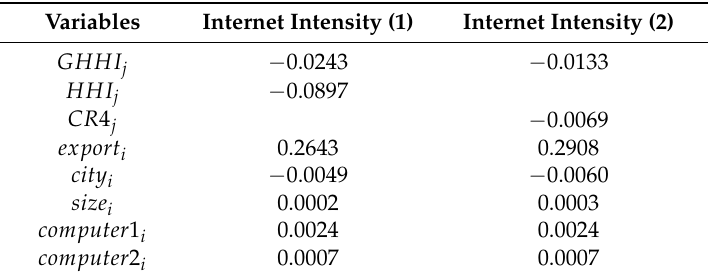
Table 7. Marginal effect of internet intensity (unit: